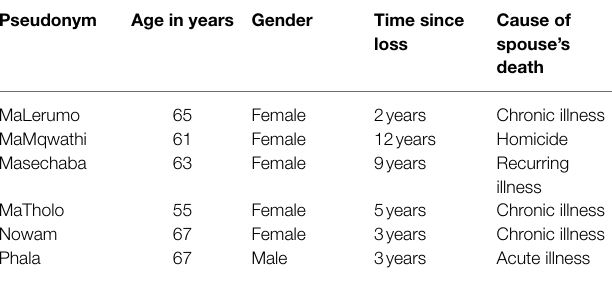
TABLE 1 | Participants’ socio-demographic and bereavement